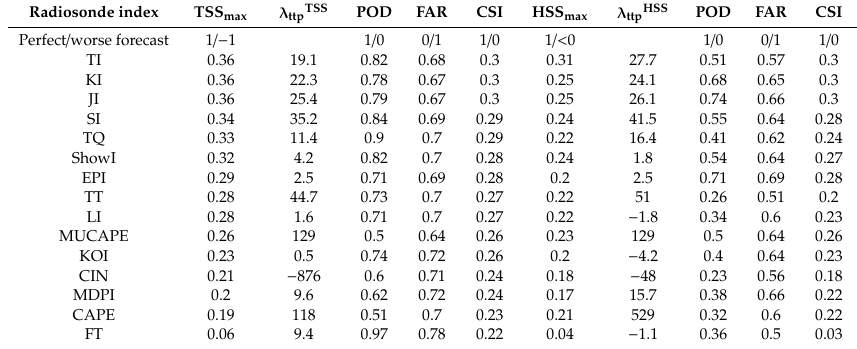
Table 4. Re-analyzed thunderstorm prediction skills of radiosonde indices using the number of flashes per minute (NLF min ) time evolution around the Institute of Applied Physics. The best indices are on the top. Radiosonde index TSS max λ